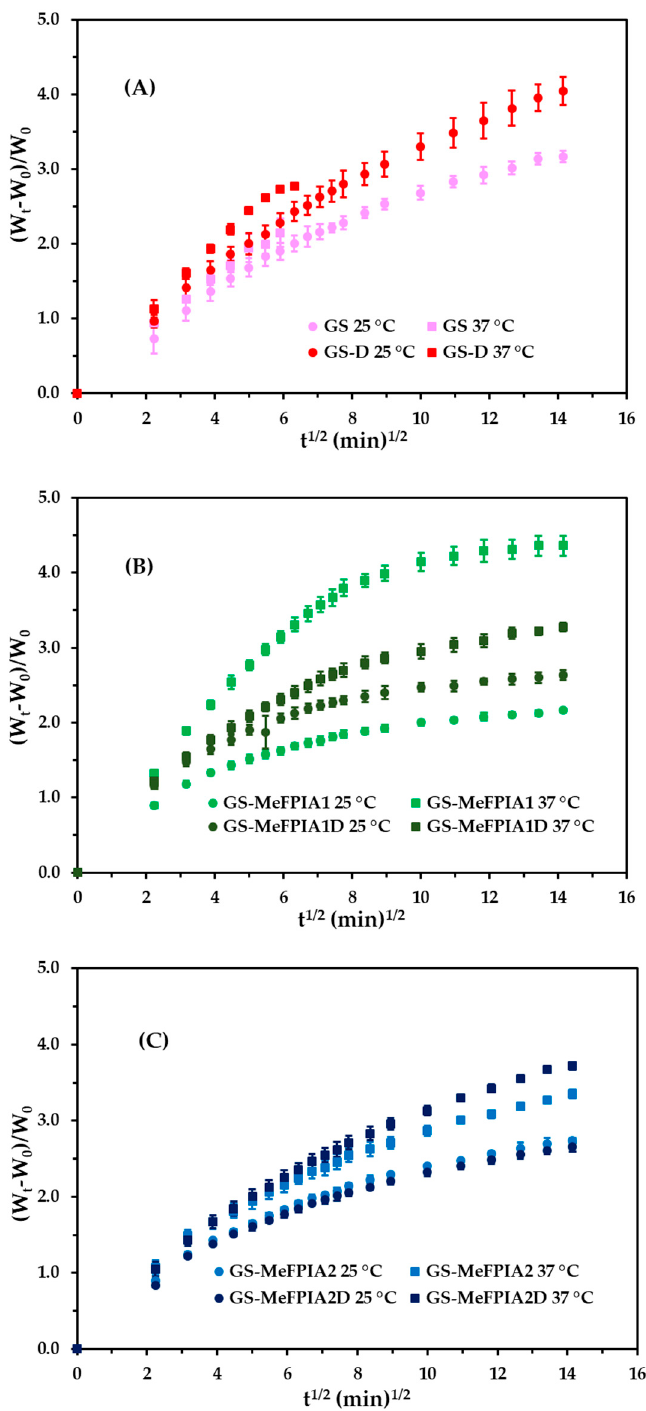
Figure 5. Representation of ( W t − W 0 )/ W 0 versus t 1/2 at 25 °C and 37 °C in PBS buffer solutions of ( A ) GS and GS-D, ( B ) GS-MeFPIA1 and GS-MeFPIA1D, and ( C ) GS-MeFPIA2 and GS-MeFPIA2D.